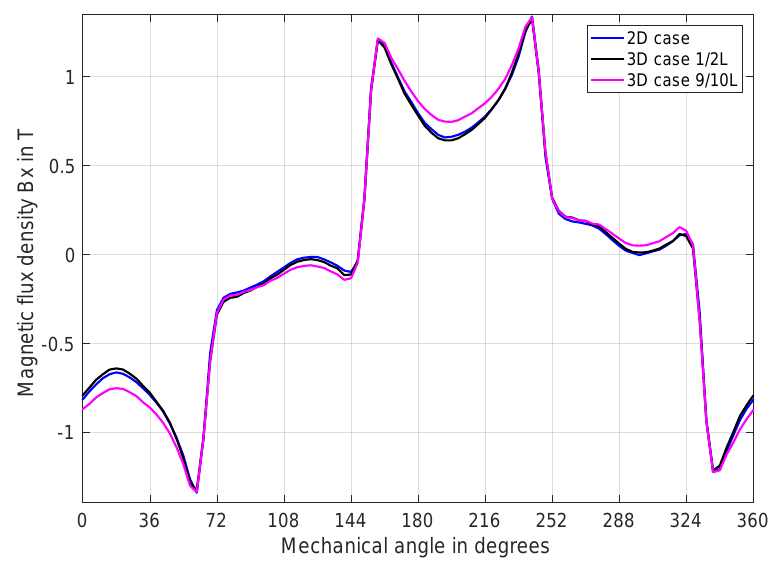
Figure 4. Comparison of B x ( r = 36.4 mm, angle = 0–360 ◦ ) between 2D and 3D simulations (inner rotor).